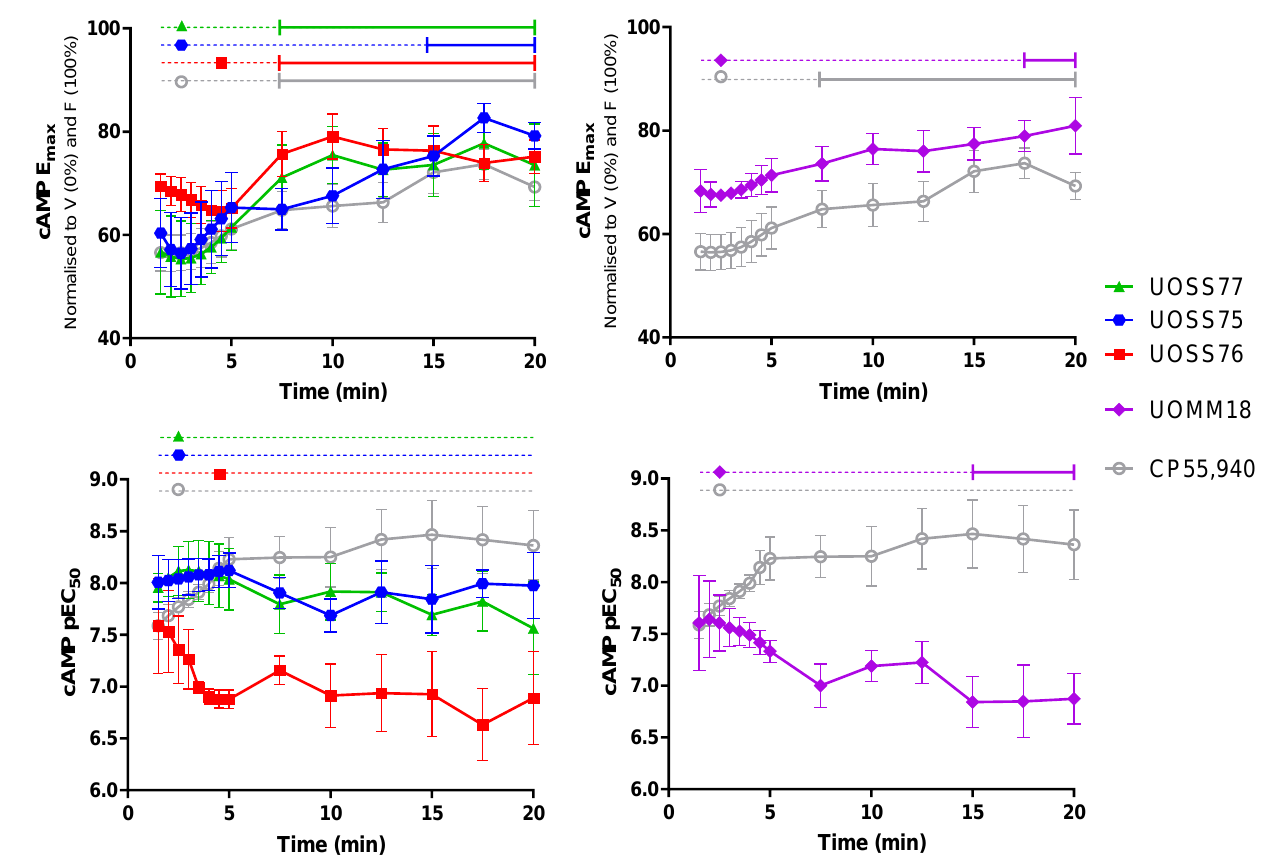
Figure 3. cAMP signalling efficacy (E max ; top panels) and potency (pEC 50 ; bottom panels) at different time-points during 20 min stimulation with compounds of interest and 5 μM forskolin. Parameters were derived from concentration response curves generated at corresponding time-points with data normalised to vehicle-treated without forskolin (V; 0%) and vehicle-treated with forskolin (F; 100%), as in Figures 2 and S1, such that smaller cAMP measurements indicate greater efficacy (inhibition of cAMP synthesis). Data are mean ± SEM from three to four independent experiments. Horizontal lines across the top of plots indicate results of within-drug statistical comparisons to the reference time-point (maximal efficacy), which is indicated by the dataset symbol. Solid capped lines indicate significant difference from the reference time-point ( p < 0.05), whereas dotted lines indicate no significant difference from the reference time-point.